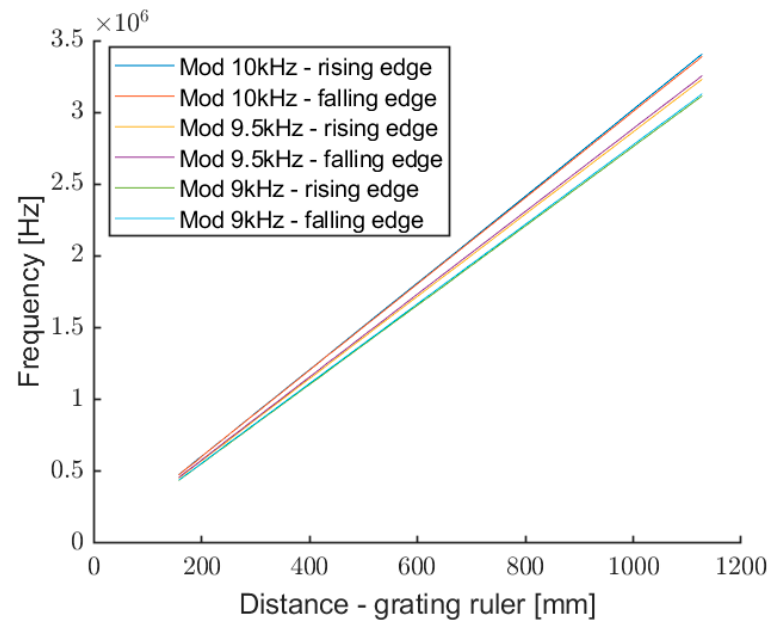
Figure 10. Frequency of the self-mixing signal as a function of the target distance, for rising and falling edges of the three modulation